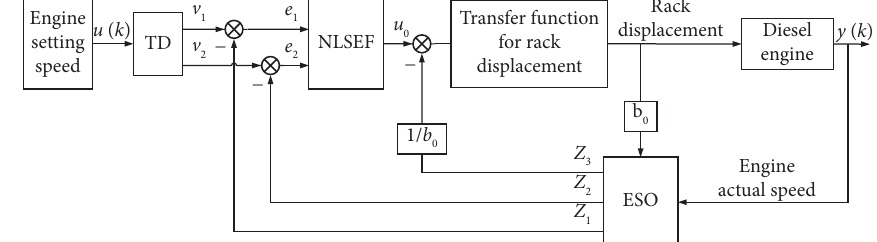
Figure 10: Structure diagram for the designed ADRC.